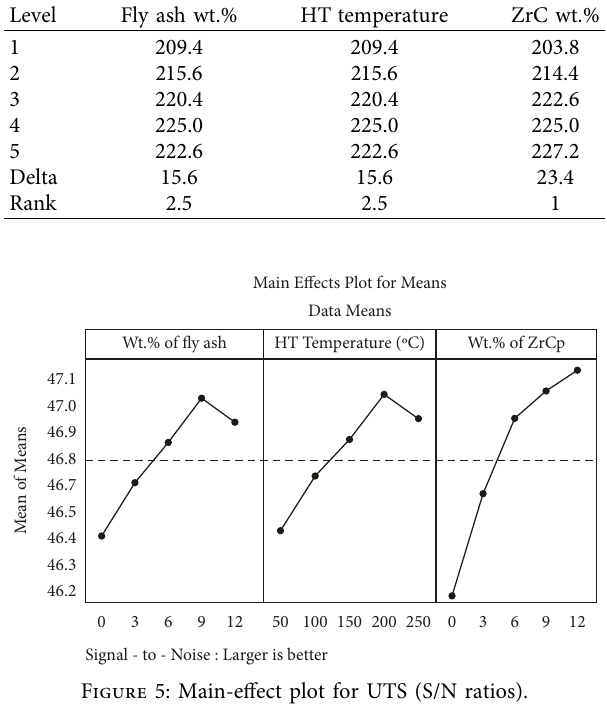
Figure 5: Main-effect plot for UTS (S/N ratios).